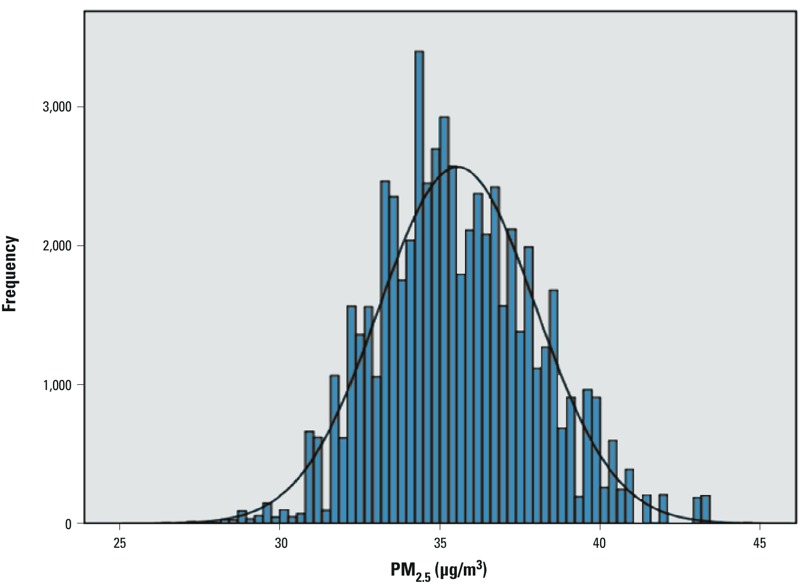
Distribution of PM2.5 estimated at geocoded addresses of participants (n = 59,591). The width of each bar (x-axis) represents a class interval for a range of PM2.5 exposure proxy of individuals, and the height (y-axis) represents the frequency of addresses in that class interval.